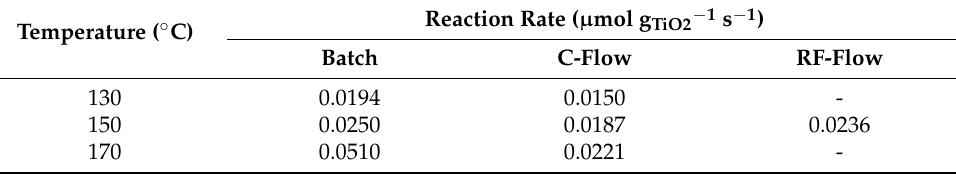
Table 2. Reaction rate in the batch reactor, conventionally heated flow reactor and RF-heated flow reactor over the T-50 catalyst.